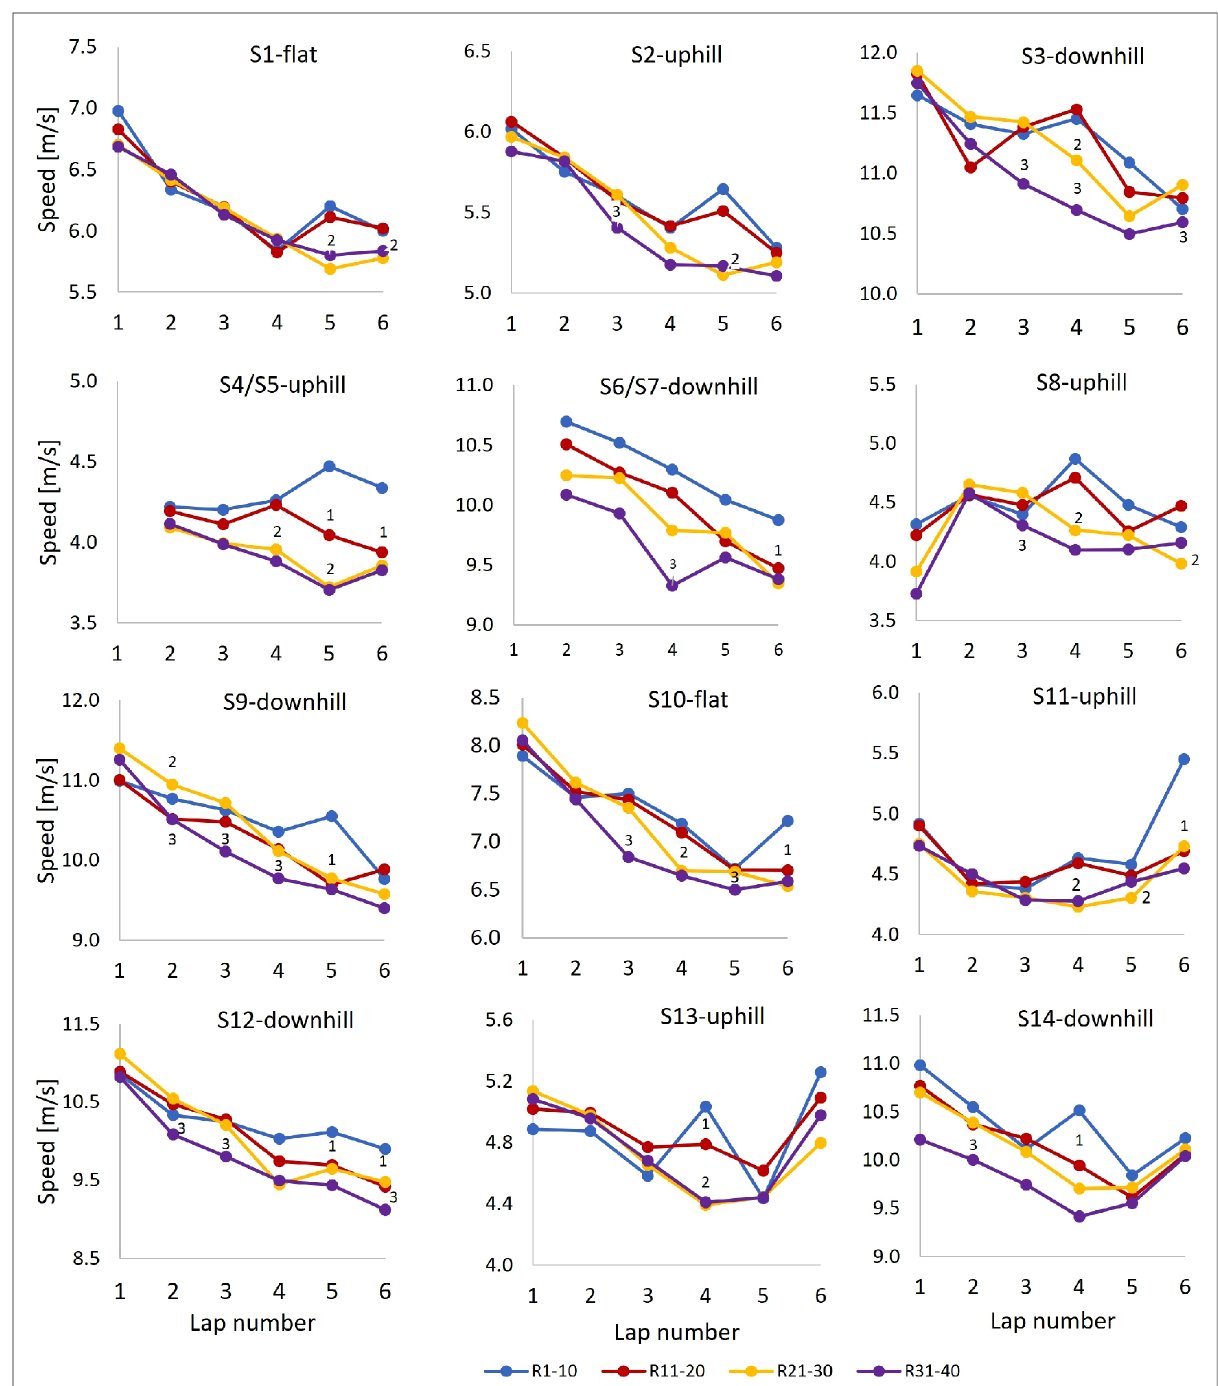
FIGURE 8 Average speed for each segment ( S ) as a function of lap number for the different performance groups during a 21.8 km cross-country skiing mass- start competition. Note that the speed for S8 on Lap 1 is lower than other laps due to lower speed into this segment since the downhill segment S6 was not included in Lap 1. Signi fi cant differences in corresponding speed-values between successive performance-groups are visualised in the fi gures. R1 – 10 (group 1) denotes ranks 1 – 10, R11 – 20 (group 2) ranks 11 – 20, R21 – 30 (group 3) ranks 21 – 30, and R31 – 40 (group 4) ranks 31 – 40. “ N ” on the plots denotes that speed-value for current group was signi fi cantly different from group N .